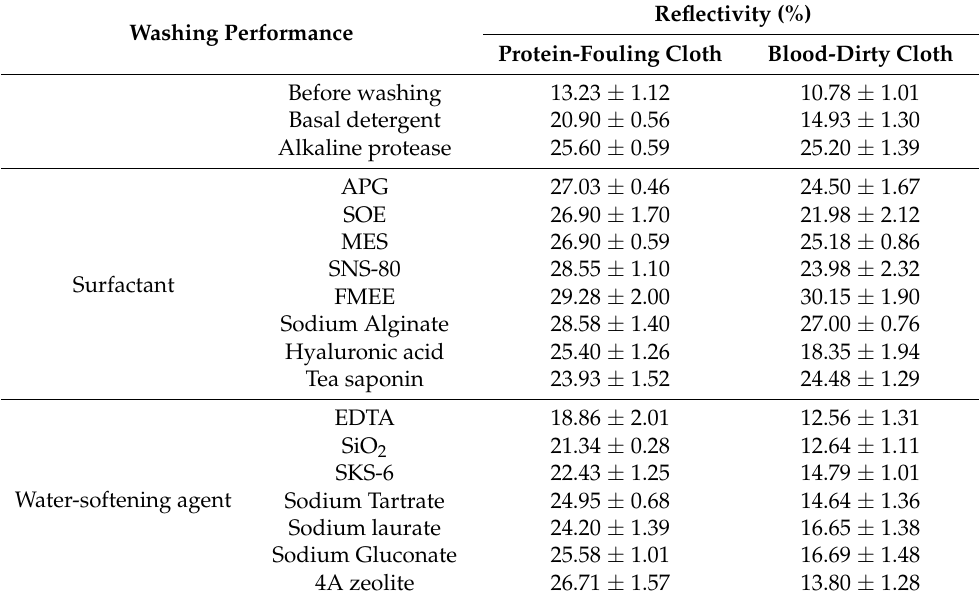
Table 2. Washing effect of different surfactants and water-softening agents mixed with alkaline protease on dirty cloth.